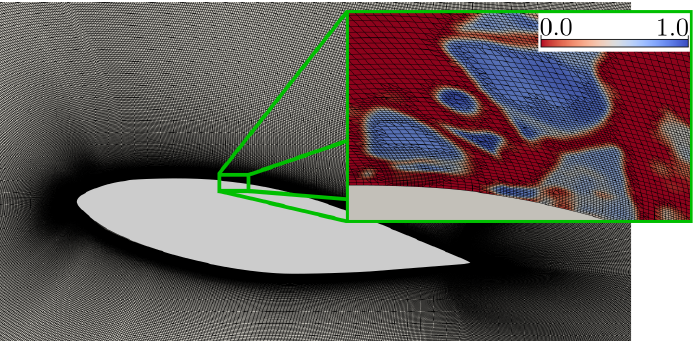
y plane. Blow-up shows an instantaneous −